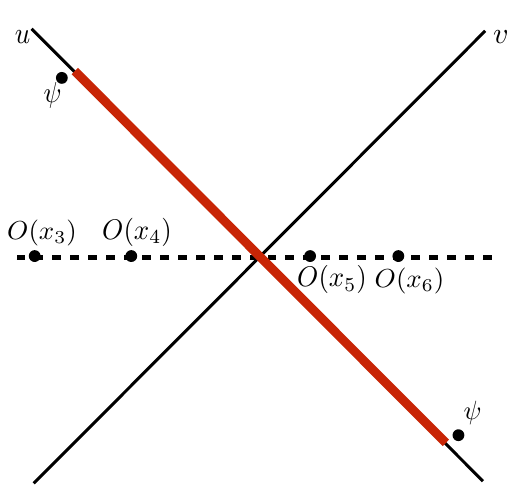
Figure 2 . Operator insertions in Minkowski spacetime. In the limit where the two ’s become null, but are widely separated in u , the leading non-identity term in the OPE is over the red null